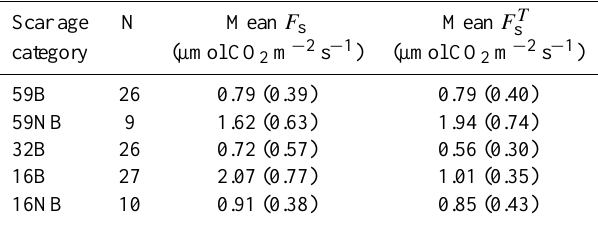
Table 1. Descriptive statistics of soil surface CO 2 flux data obtained from five fire scar age categories at Sharpsand